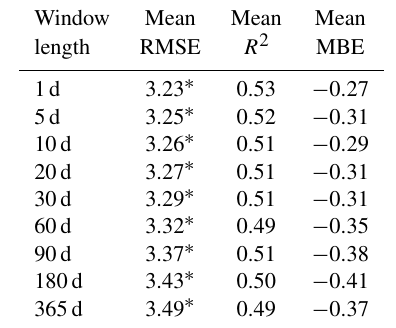
Table 6. The average RMSE, R 2 , and MBE for F c gap-filling based on the window length, including the outcome of all sites; the differ- ences of RMSE values were tested using the Tukey’s HSD test at the level of 0.05.